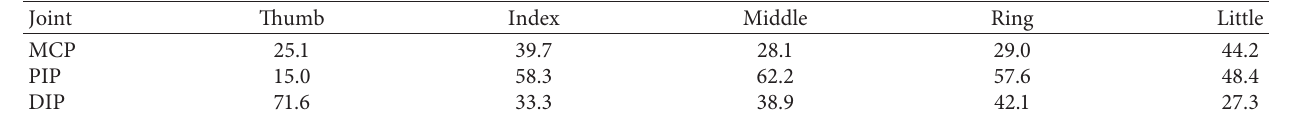
Table 6: Angular maximum displacement for each joint of all five fingers ( ° ).